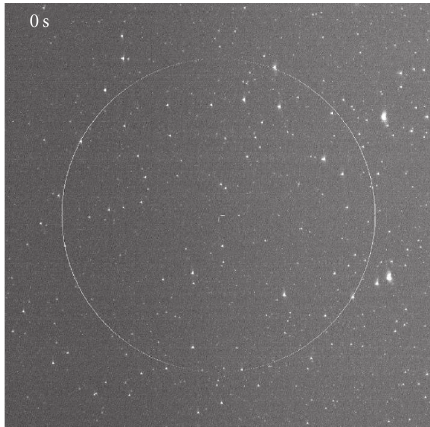
Figure 17: The most recent error box of GRB081130B α = 00 h 56 m 20 s δ = +04 ◦ 12 (cid:3) , error-box radius is R = 3 . 5 ◦ [11]. The cen- tre of the field of view of the camera that which recorded the burst pointed at α = 01 h 01 m 56 s δ = +19 ◦ 20 (cid:3) 38 (cid:3)(cid:3) . The image size is 10 ◦ × 10 ◦ . Animation available here: http://observ.pereplet.ru/images/ GRB081130B/grb